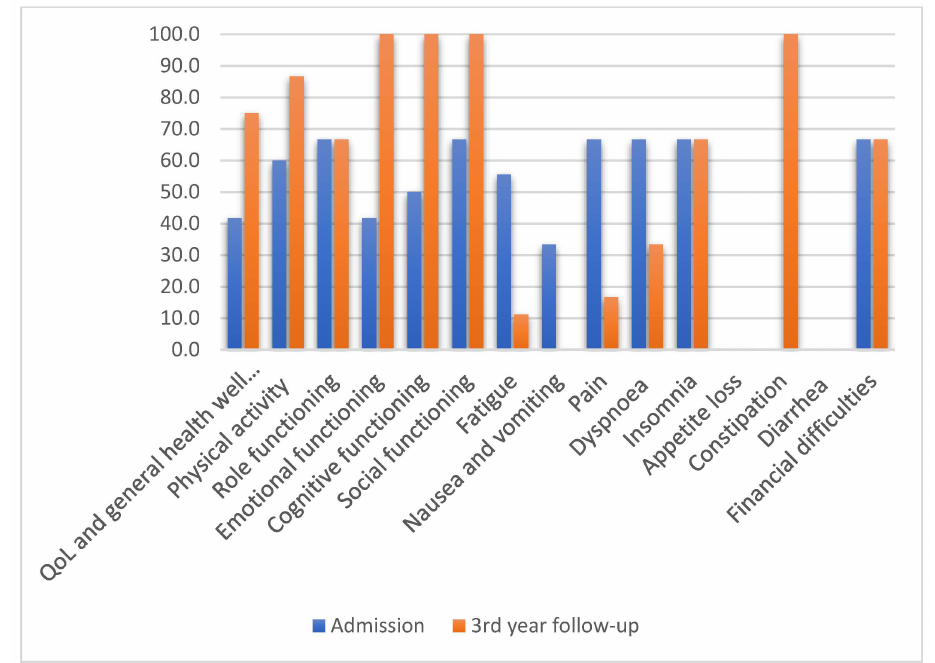
Figure 1. QLQ-C30 mean values after total laryngectomy with VP (N =